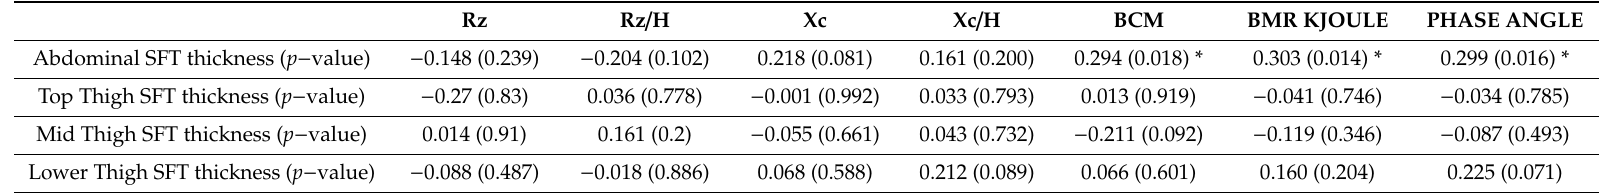
Table 5. Correlation between abdominal / thigh subcutaneous fat thickness and BIVA parameters in hemodialysis